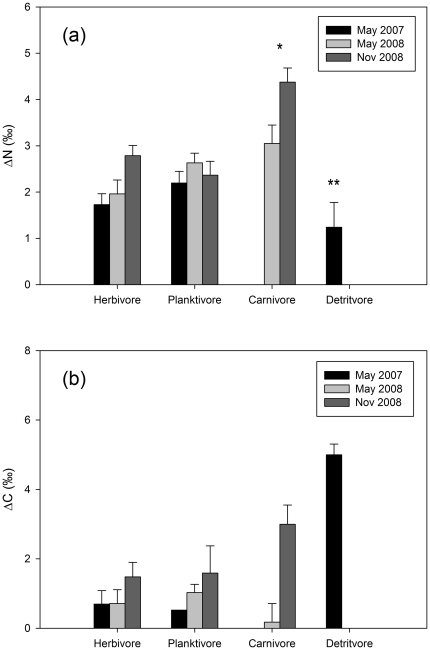
Discrimination factors by trophic group.Data is shown for herbivorous, planktivorous, carnivorous and detritivorous trophic groups in terms of (a) nitrogen (ΔN) and (b) carbon (ΔC). Data are mean ± s.e. (n as per Table 1); * and ** denote significantly different trophic groups (no significant seasonal differences or season×trophic group interactions).